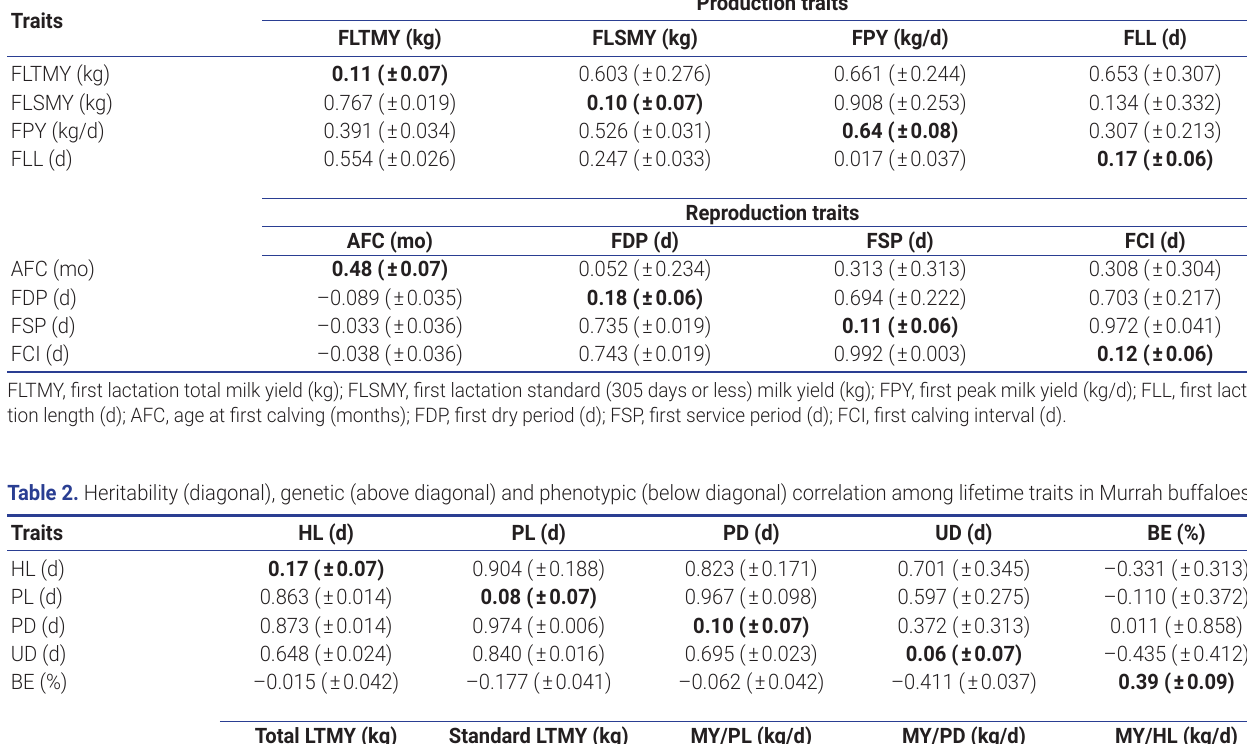
Table 1. Heritability (diagonal), genetic (above diagonal) and phenotypic (below diagonal) correlation among first lactation traits in Murrah buffa - loes Traits